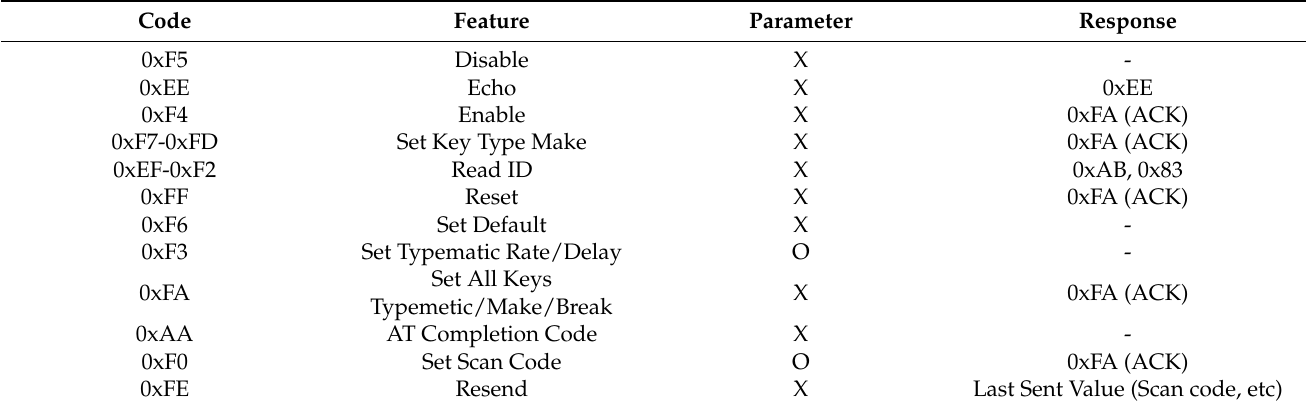
Table 4. Primary control codes of keyboard controller.